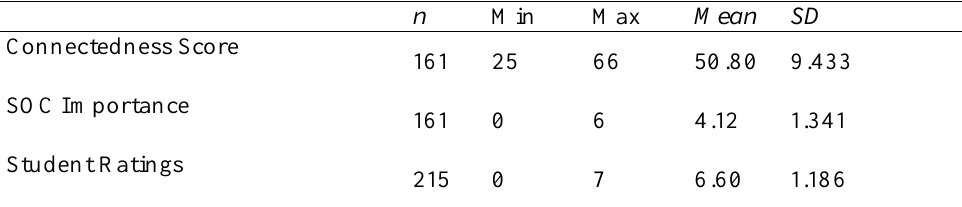
n Min Max Mean SD 161